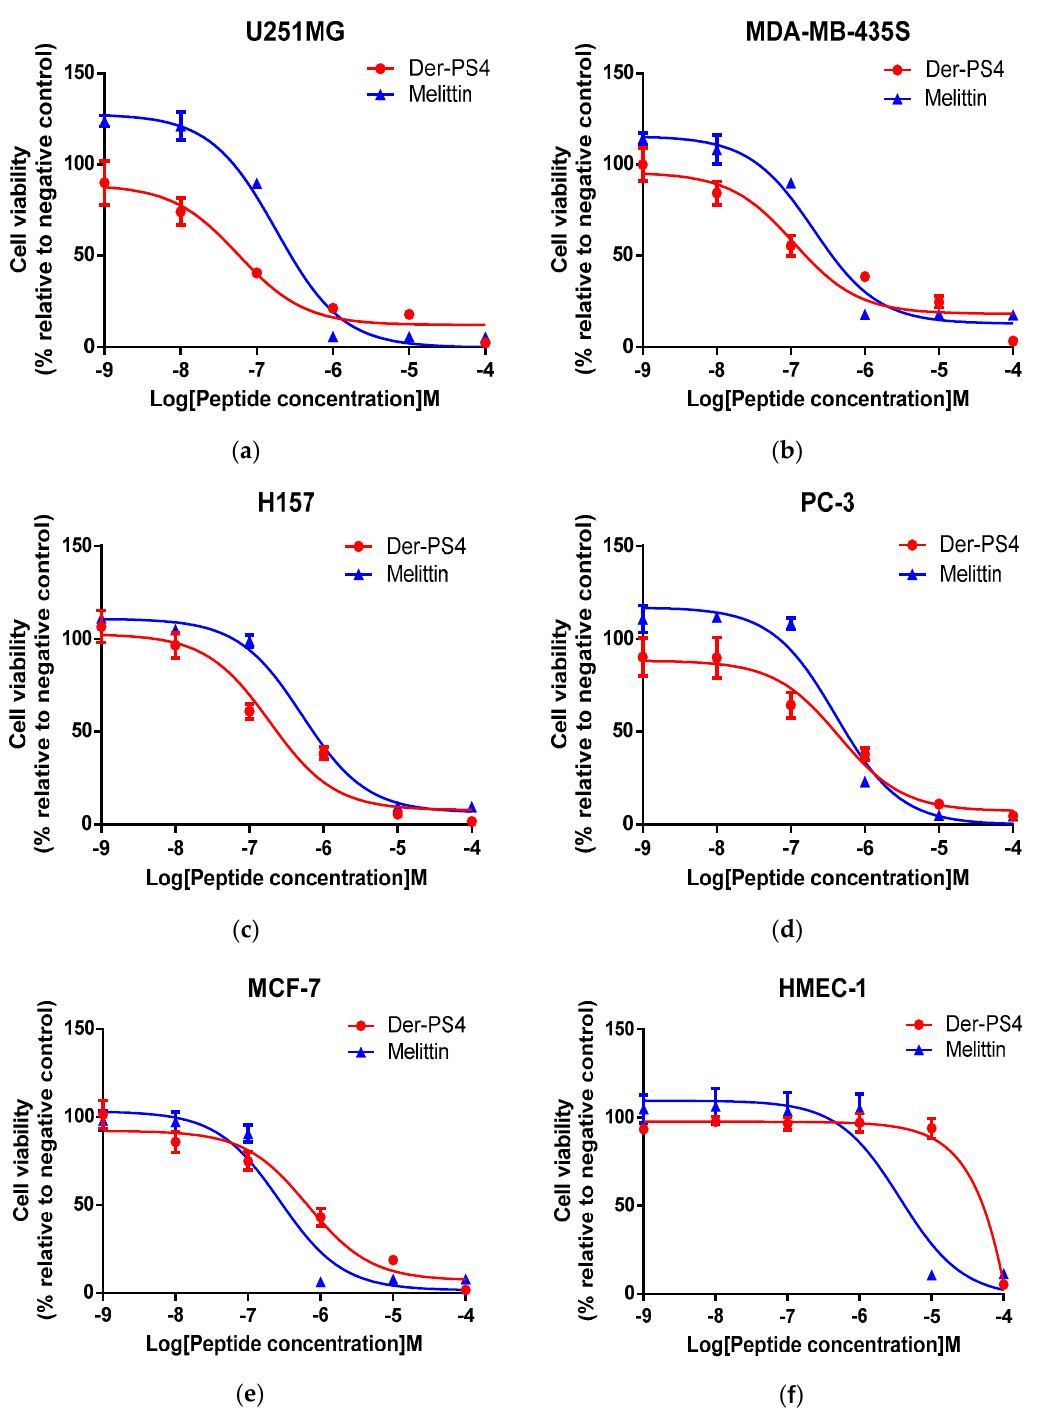
Figure 10. The e ff ect of Der-PS4 on proliferation of human cancer cell lines: U251MG ( a ), MDA-MB-435S ( b ), H157 ( c ), PC-3 ( d ), MCF-7 ( e ) and human dermal microvascular endothelium cell HMEC-1 ( f ) after treated with Der-PS4 for 24 h in a range of concentrations from 10 − 9 to 10 − 4 M. Negative control was acquired after incubation with serum-free culture medium. Data represent means ± SEM (stand error of the mean) of five replicates.